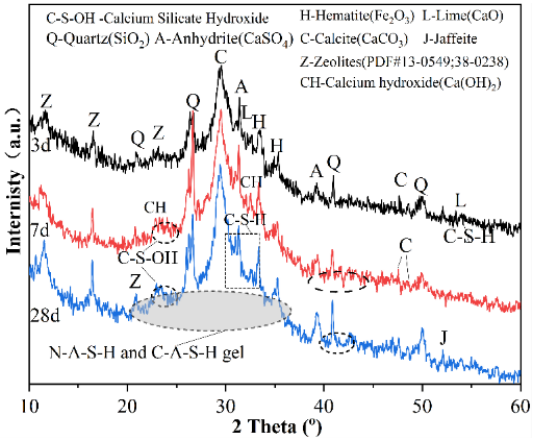
Figure 9. X-ray diffraction patterns of 3-day, 7-day, and 28-day optimal proportioning samples.